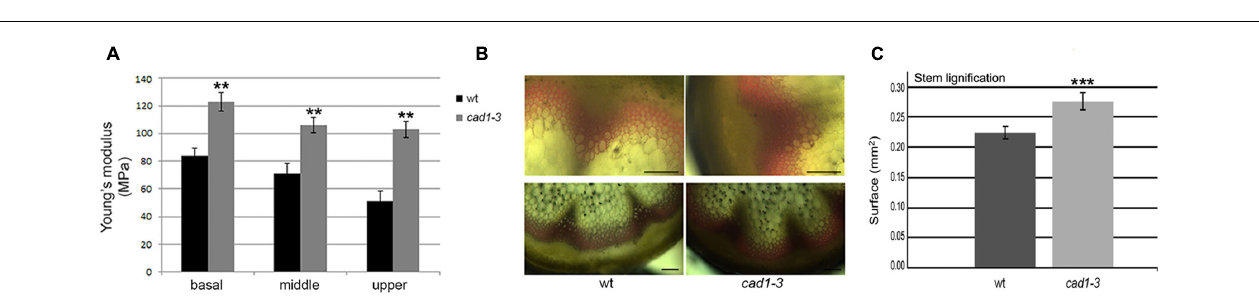
FIGURE 7 | (A) Sections from basal, middle and upper zones of wt and cad1-3 stems subjected to stretch. Pressure (MPa) required by the Instron instrument to break the stems is shown. n = 6, error bars indicate SE; statistics as in Figure 1 . (B) Stem sections from the basal zone stained with phloroglucinol. The reddish color visualizes lignin accumulation. Representative results of three independent experiments are shown. Scale bars = 100 µ m. (C) Morphometric analysis on lignified area (mm 2 ) from stem sections (basal zone) performed with ImageJ software. n = 6, error bars indicate SE; statistics as in Figure 1 . ∗∗∗ p ≤